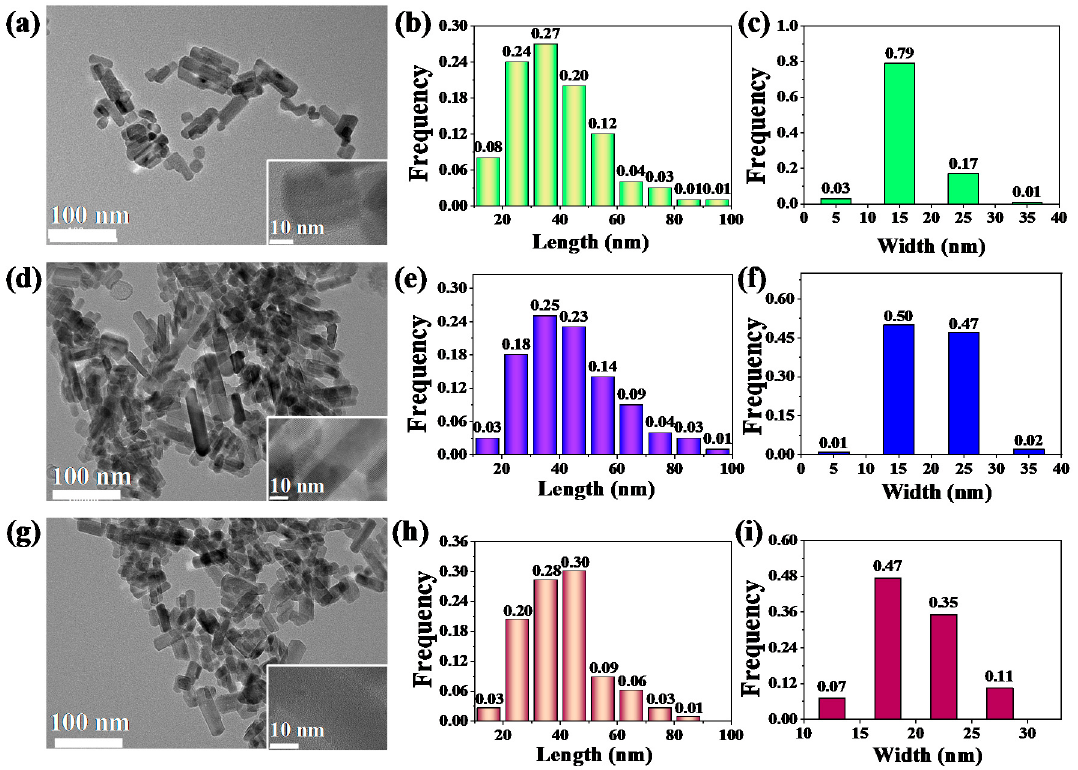
Figure 1. TEM of the nanorods with different Mn 2+ addition and statistical results of their length and + : ( a – c ); 0.25% Mn 2 + : ( d – f ); 0.5% Mn 2 + : ( g – i width (0.1% Mn 2+ : a , b , c ; 0.25% Mn 2+ : d , e , f ; 0.5% Mn 2+ : g , h , i ). width (0.1% Mn 2